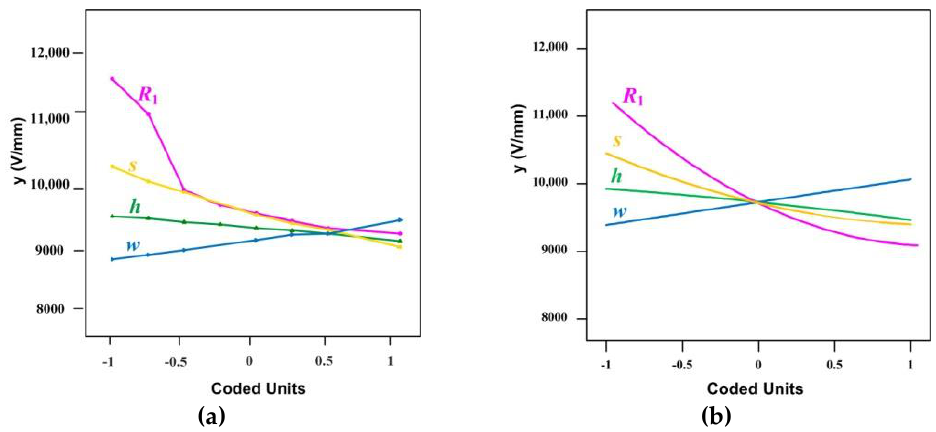
Figure 9. Comparison of optimization results: ( a ) FEM; ( b ) RSM.